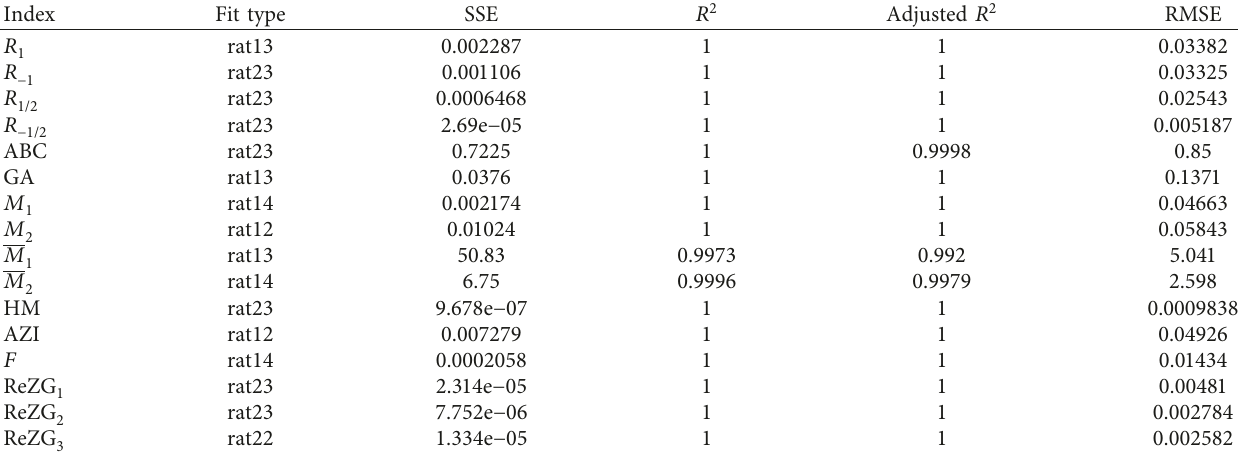
Table 35: Goodness of fit for indices vs. entropy for Nb